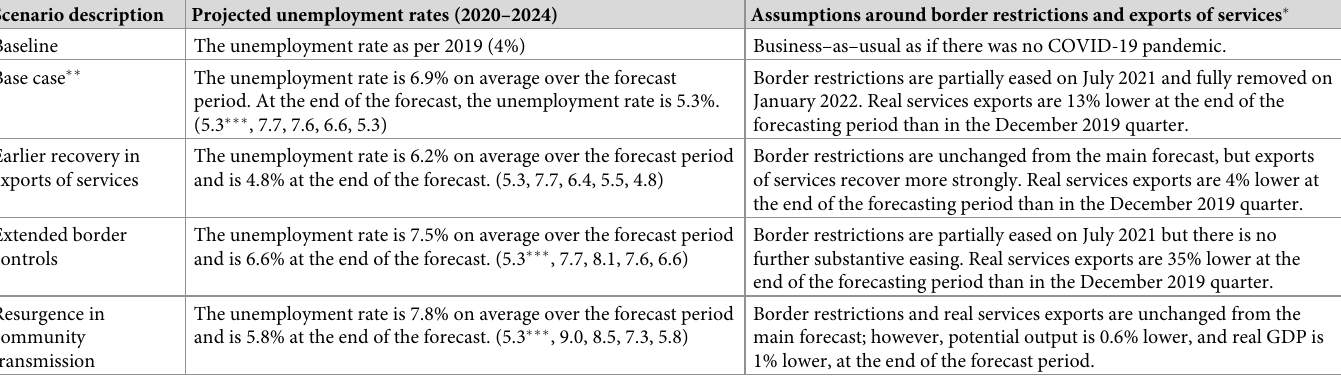
Table 1. Projected unemployment scenarios in NZ as a result of the COVID-19 pandemic and response to it (extracted from a NZ Treasury Report) [23, 30]. Scenario